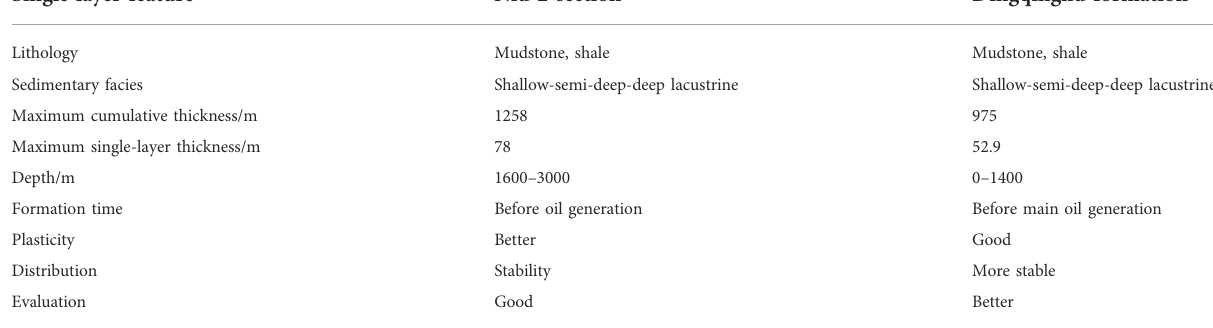
TABLE 4 Macroscopic development characteristics of Paleogene seals in Lunpola